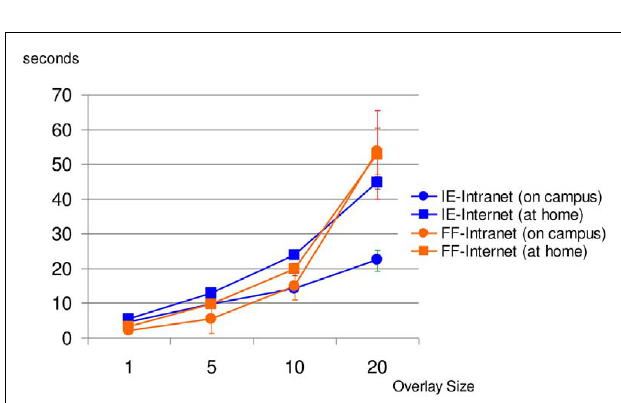
FIGURE 12 | System-level fiber tracts in the KESM Golgi data set 2. (A) Horizontal section at the level of the anterior commissure (the “)”-shaped fiber bundle) is shown (left: anterior, right: posterior). Massive fiber tracts in the striatum can also be observed.